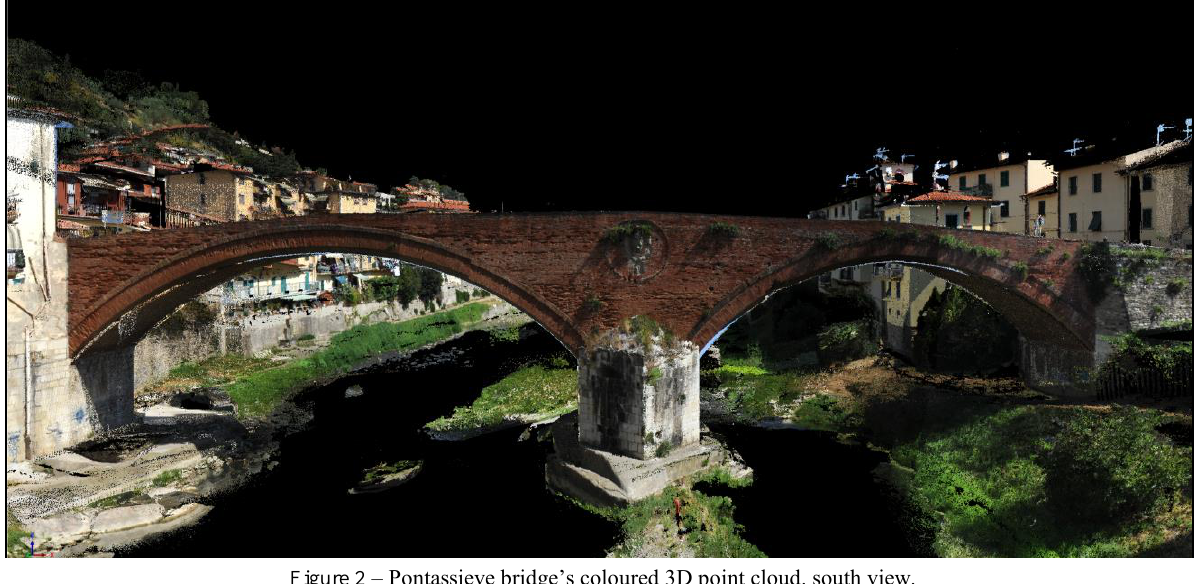
Figure 2 – Pontassieve bridge’s coloured 3D point cloud. south view.